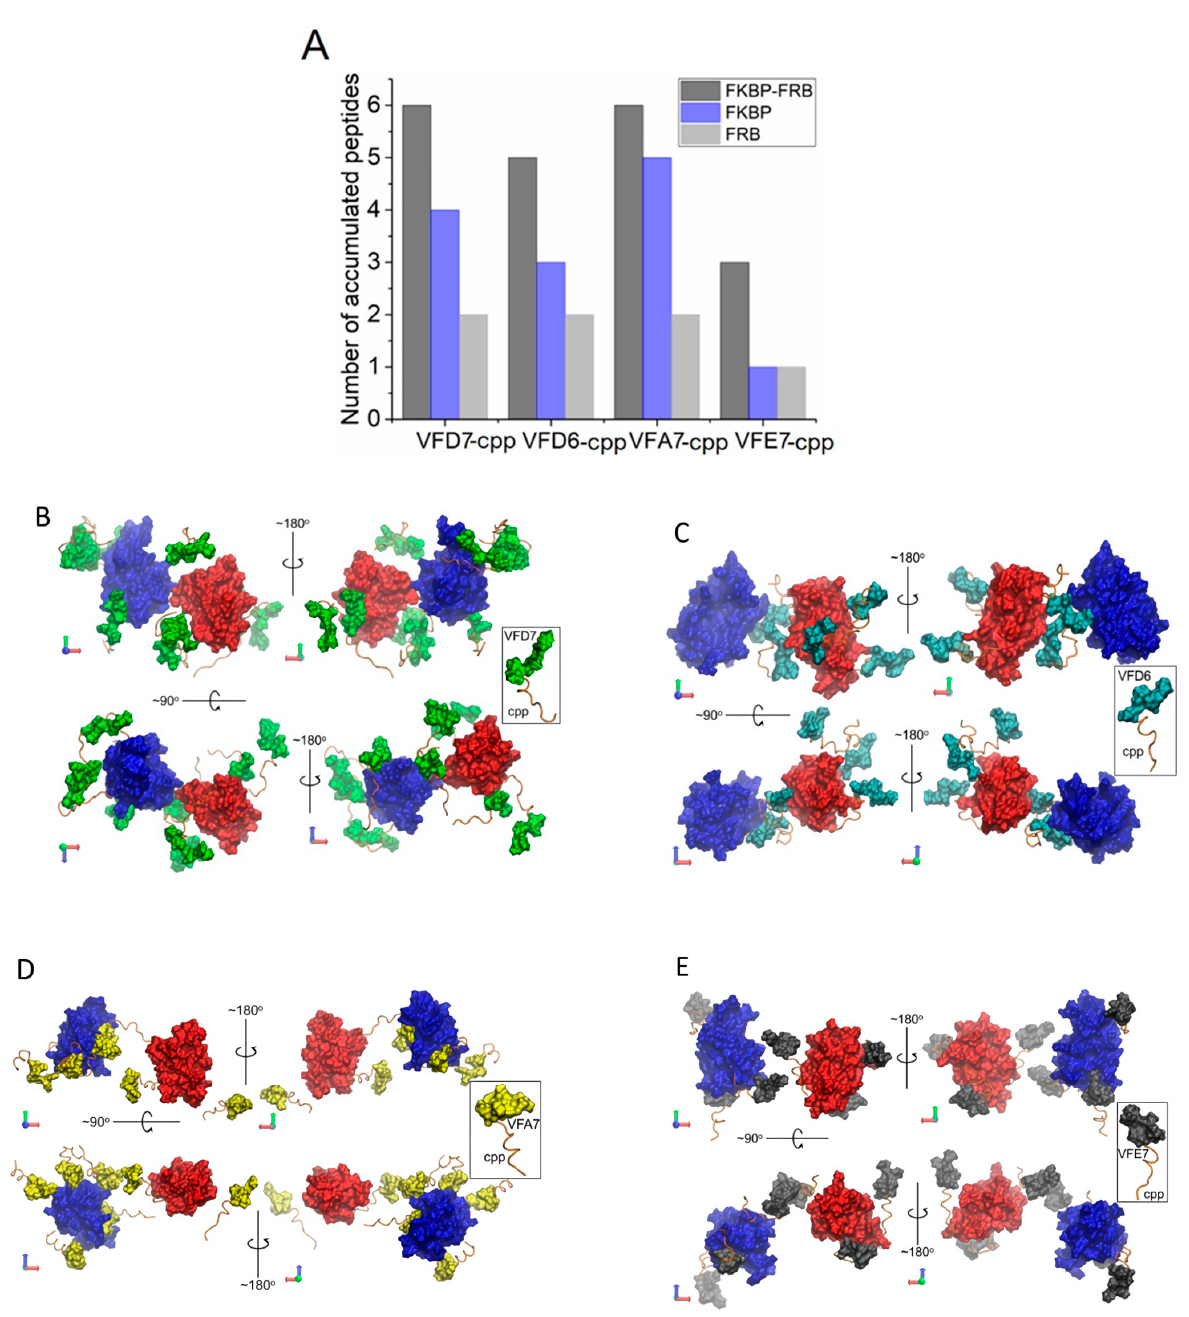
Figure 7. Peptides stabilized on the protein surfaces. ( A ) The average number of peptide molecules close to the FKBP and FRB domains. ( B – E ) Structures at the end of the simulation trajectories showing the direct interaction between the peptides and both FKBP and FRB proteins. Highlighted in the small boxes are the peptides’ predicted structures.